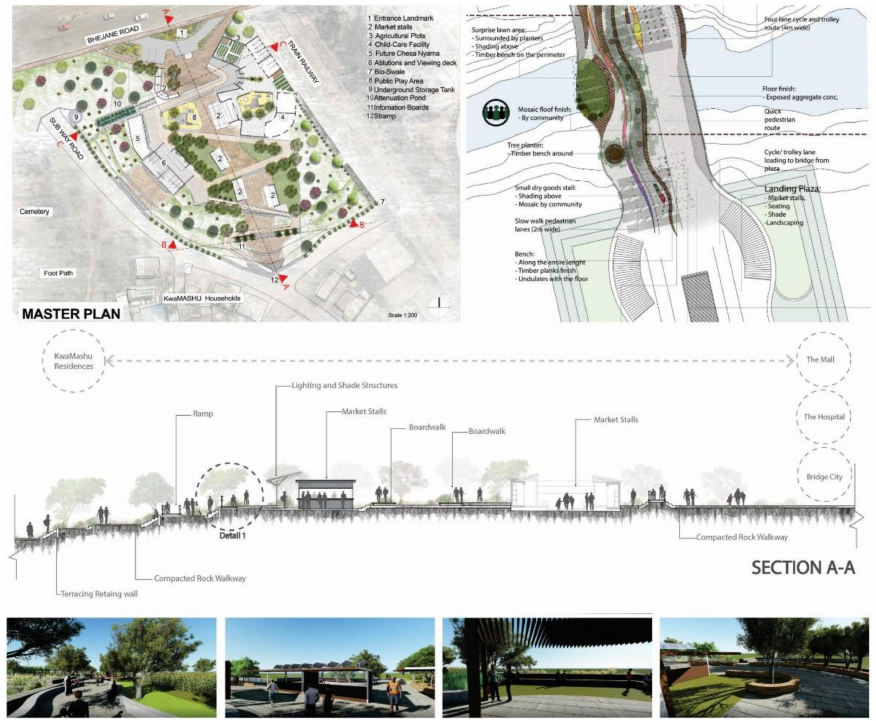
Figure 9. A collage with selected design work from the students that was shared with the eThekwini Municipality. The top left and middle images feature a linking market space on a steep slope to Bridge City. The top right and bottom images feature a pedestrian bridge crossing the Piesang’s River with recreational lookout points. Source: University of Pretoria, Department of Architecture,